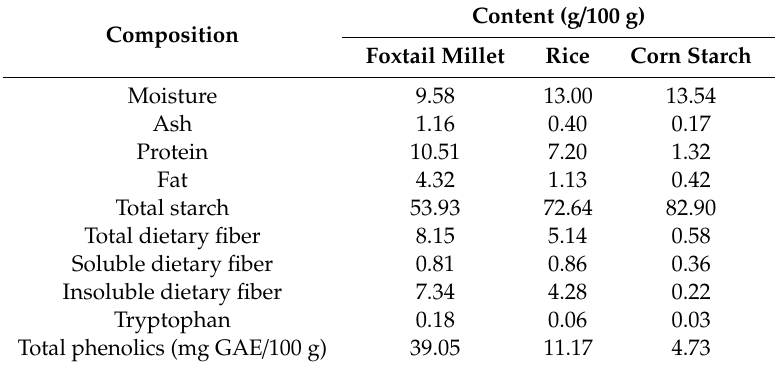
Table 2. Composition of millet, rice, and corn